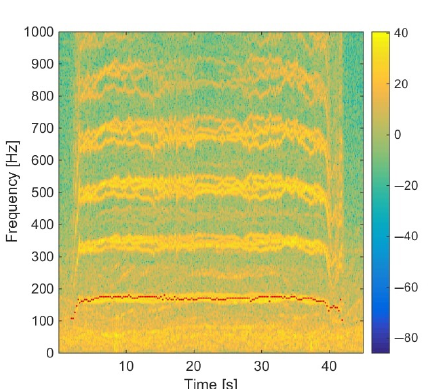
Figure 13. Spectrogram of the experimental trajectory (the red points are the estimated fundamental frequencies detected by SHC corresponding to f bp